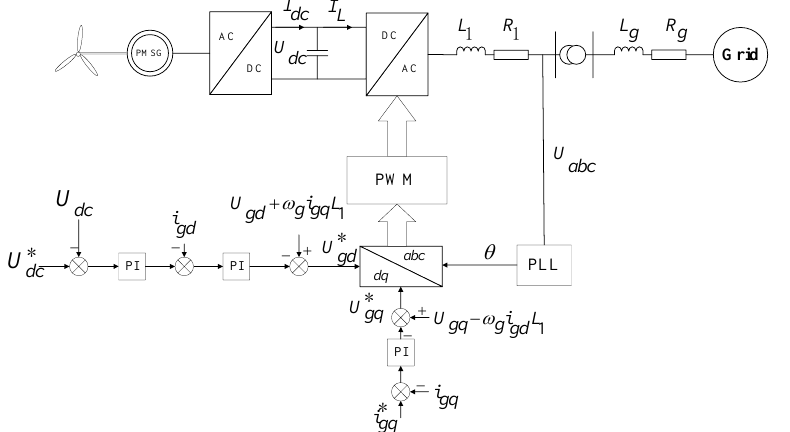
Figure 1. The PMSG-based wind farm diagram. To develop a mathematical model for studying SSR in PMSG-based wind farms, dif- ferential equation models for GSC, full-scale controls of GSC controller, and PLL must be established. Line current and DC bus voltage [ i gd , i gq , U dc ] can be used to form the GSC model (Equation (1)), while intermediate state variables [ x 1 , x 2 , x 3 ] can be selected for the GSC controller (Equation (2)). The PLL adopts a space vector transformation structure to provide orientation angle for GSC output voltage, The principal diagram of PLL of d axis orientation is shown in Figure 2 and its linearization can be expressed by Equation (3).